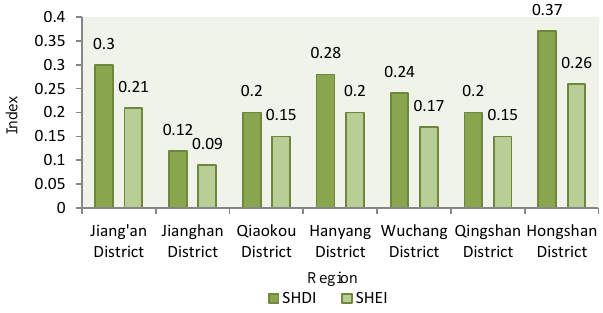
Figure 4. Landscape diversity of parks and green spaces in the main urban area of Wuhan.